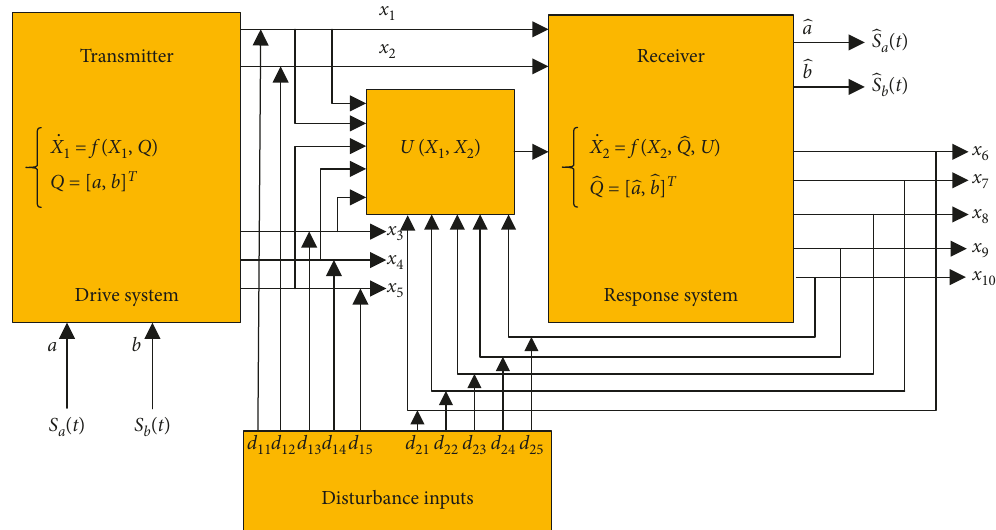
Figure 9: Secure communication scheme based on two-input and two-output with partial uncertainty parameters and disturbance